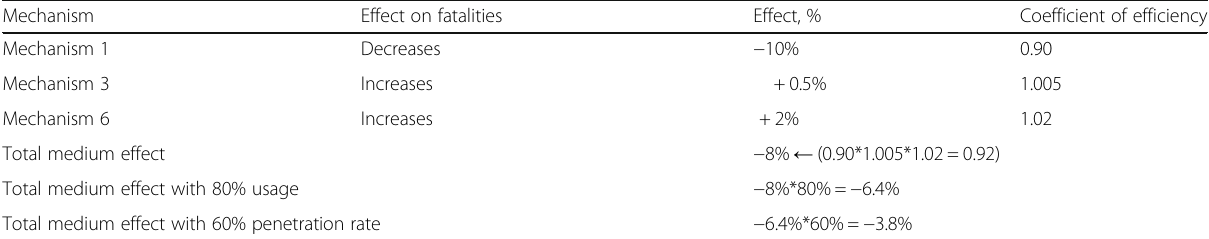
Table 4 An illustrative example of calculation of the total effect on fatalities based on percent